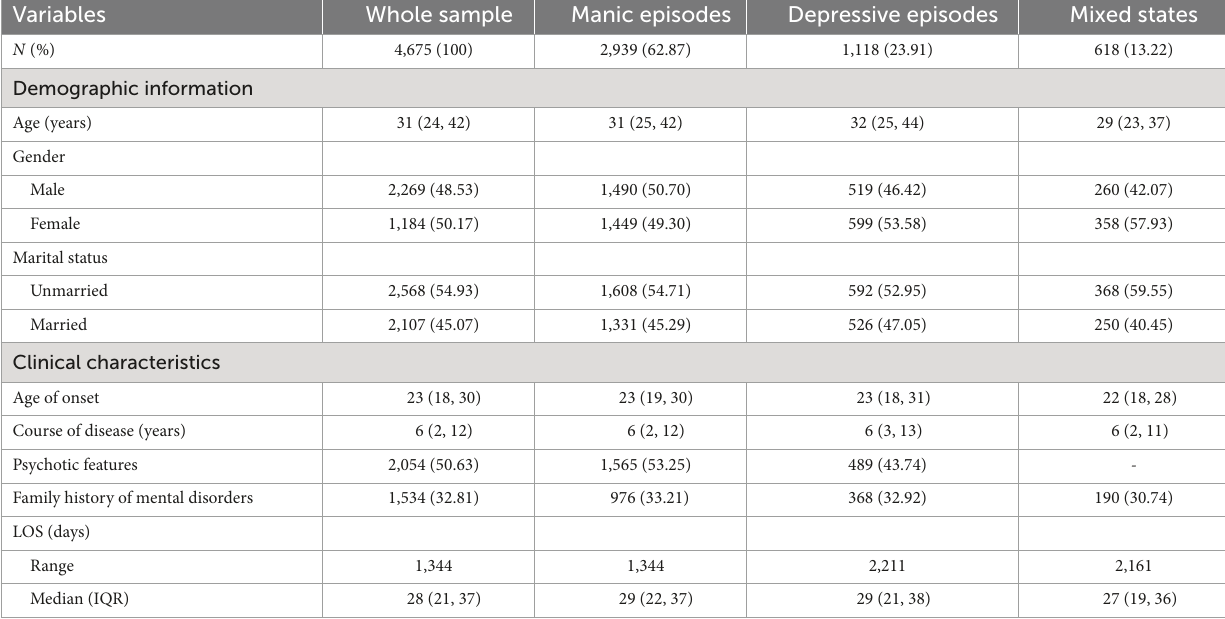
TABLE 1 Demographic information and clinical characteristics of the whole sample and the three polarities.